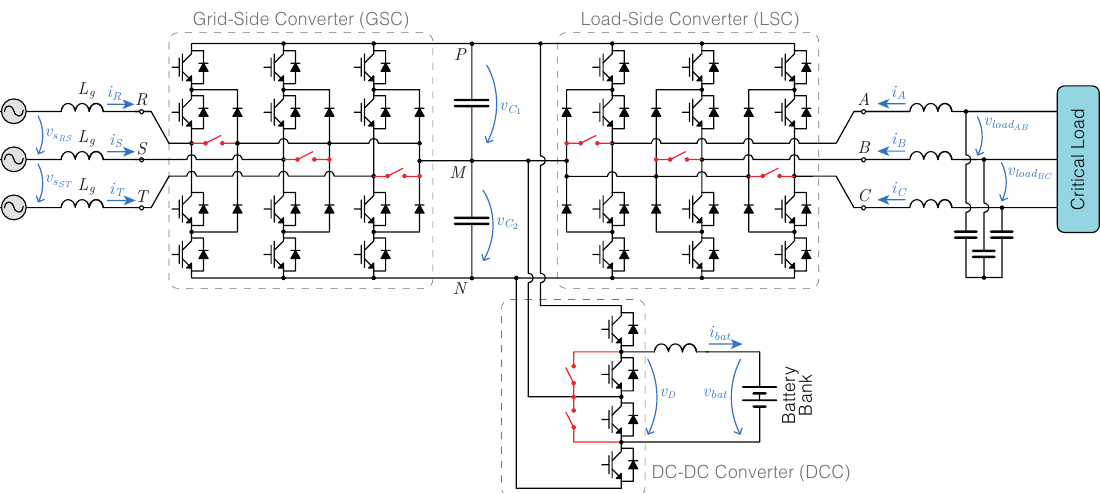
Figure 1. Proposed non-redundant fault-tolerant UPS topology (additional hardware shown in